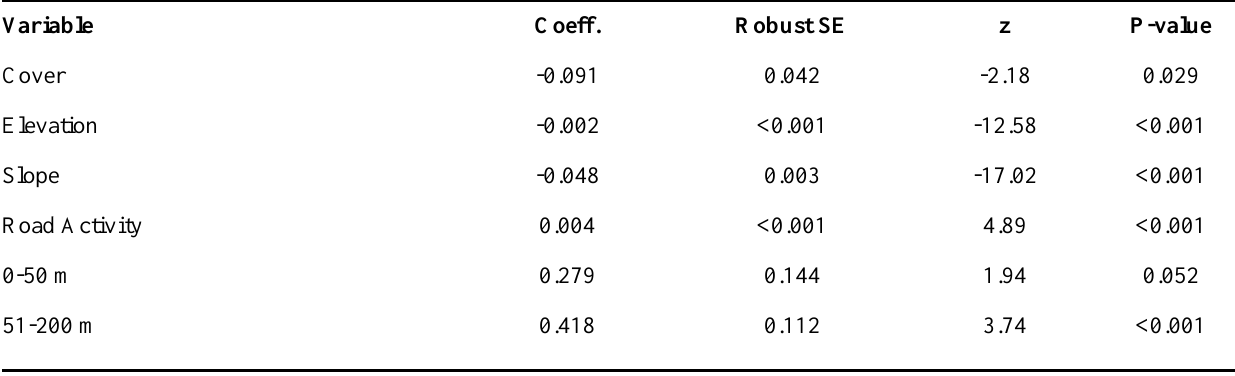
Table A1.2 . Model results for wolves near roads. Results predict wolf occurrence near roads using matched case-control logistic